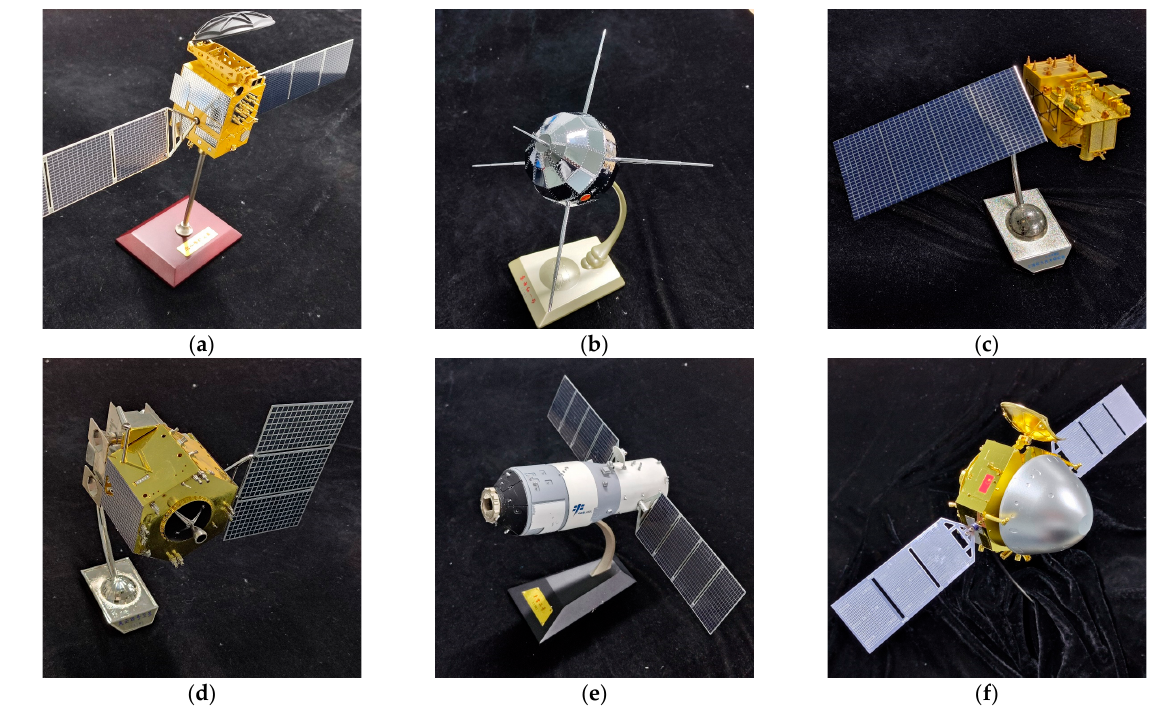
Figure 5. The model used for the validation dataset: ( a ) Beidou; ( b ) DFH; ( c ) FY-3; ( d ) FY-4; ( e ) TG; ( f ) TW.